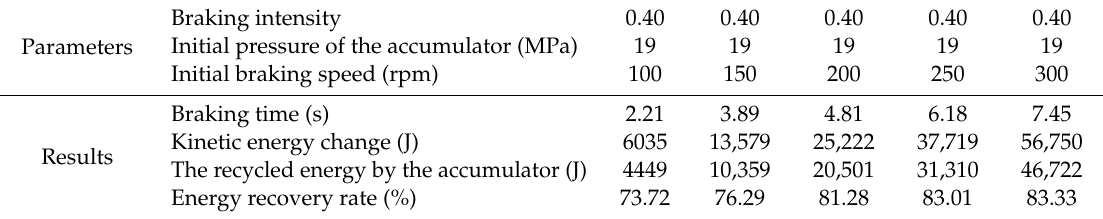
Table 8. The experimental results in the operating mode with di ff erent initial braking speed.